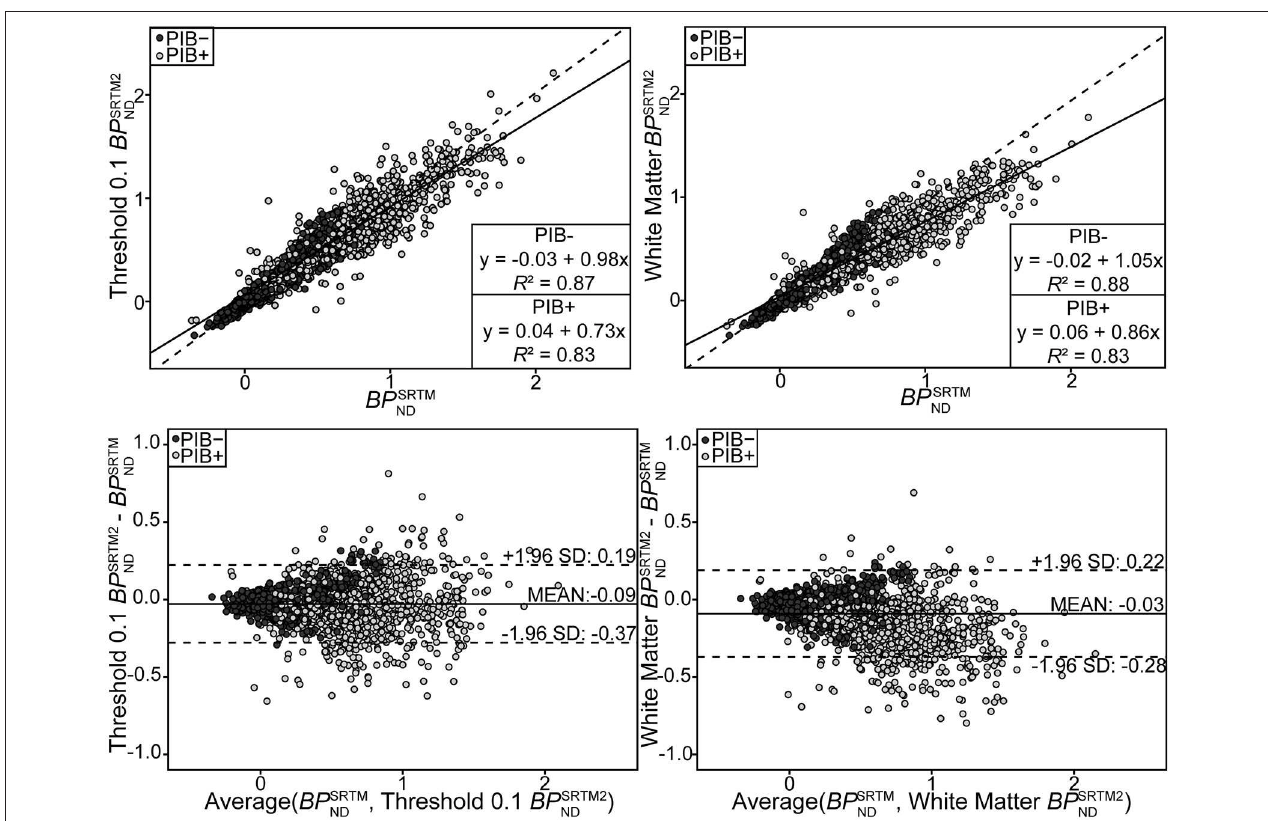
FIGURE 5 | Scatter plot showing BP SRTM 2 ND estimates (y-axis) from Threshold 0.1 (top left) and White Matter (top right), and BP SRTM ND values (x-axis). Lines resulting from the linear regression applied to the data are also shown, a full line for the PIB + group, and a dashed line for the PIB–. Results of the linear regression are given in boxes at the bottom right corner of each plot. Bland-Altman plot showing the difference between the values of BP ND assessed by different SRTM2 methods (by Threshold 0.1 on the bottom left, and by White Matter on the bottom right) from SRTM. The full line is at the mean difference values for the group, and the dashed lines delimit the 95% agreement interval (at mean ± 1.96 × standard deviation). Dark gray circles represent data from the PIB– patients, and light gray, from the PIB +